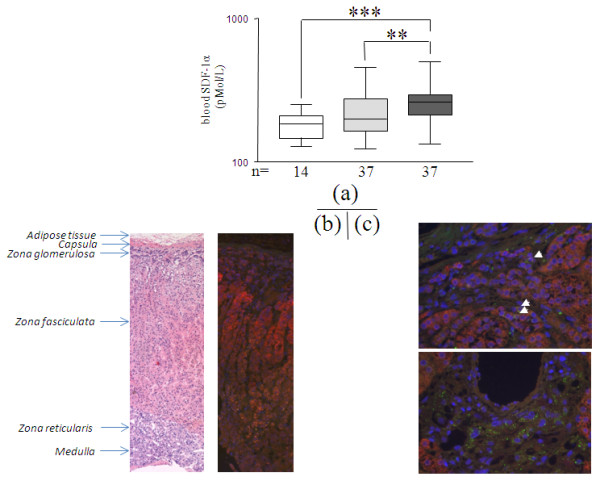
On ICU-admission blood concentrations of SDF-1α(CXCL-12) and expression of its receptor (CXCR4) in adrenal gland. The three groups were compared in bar charts as described in Figure 1, and represent (a) SDF-1α (pMol/L) in studied groups. The Y axis is in logarithmic scale. P are indicative of significant difference(s) between groups: **: P < 0.01, ***: P < 0.001. (b) low magnification of a human adrenal gland (× 40) stained with H&E; and after CP450-21-hydroxylase label (red), showing dominant specific expression in the zona fasciculata, (c) sparse expression of the SDF-1α receptor CXCR4 (green labeling, white arrows) by CP450-21-hydroxylase expressing cells of a human adrenal gland cortex (zona fasciculata, red labeling, magnification × 400) (upper panel), and dominant expression of CXCR4 (green labeling) by adrenal vascular wall cells, surrounded by CP450-21-hydroxylase expressing clusters in zona fasciculata (red labeling, magnification × 400) (lower panel).